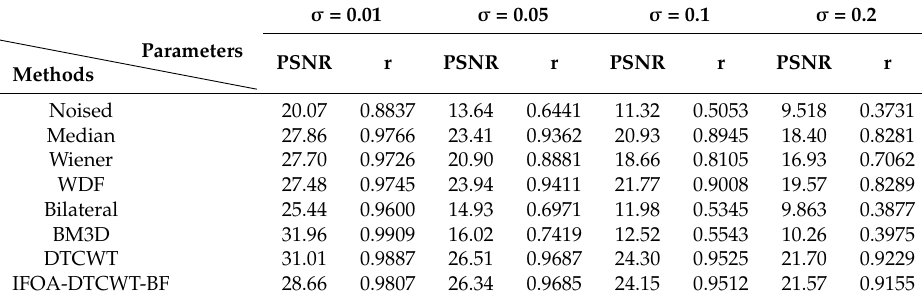
Table 2. Comparison of the five methods (Lena with Gaussian noise). WDF: wavelet decomposition filter; BM3D: block-matching and 3D filtering; DTCWT: dual-tree complex wavelet transform; IFOA-DTCWT-BF: enhanced dual-tree complex wavelet optimized by fruit fly algorithm and bilateral